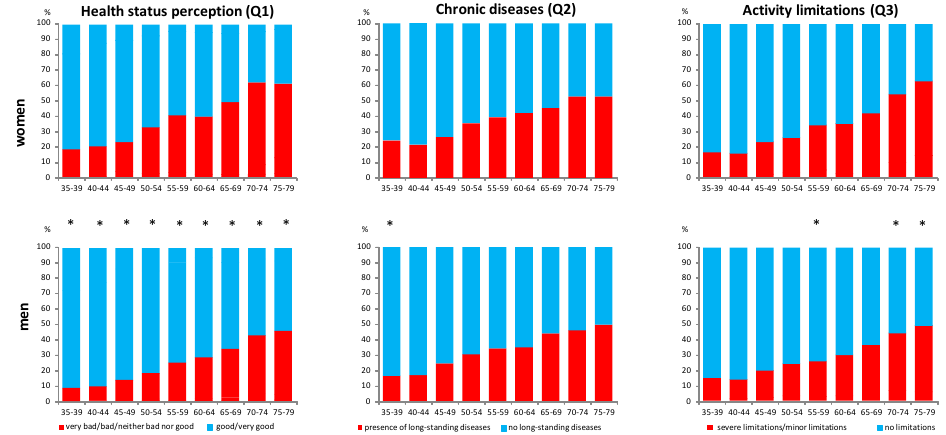
Figure A2. Frequency distributions of MEHM items dichotomized answers, expressed as percentage of number of participants within each age group, for women and men. (Data source: the CUORE Project Health Examination Survey 2008–2012, Italian men and women, 35–79 years old). * Indicates significant di ff erences between women and men age-matched groups (2, p <